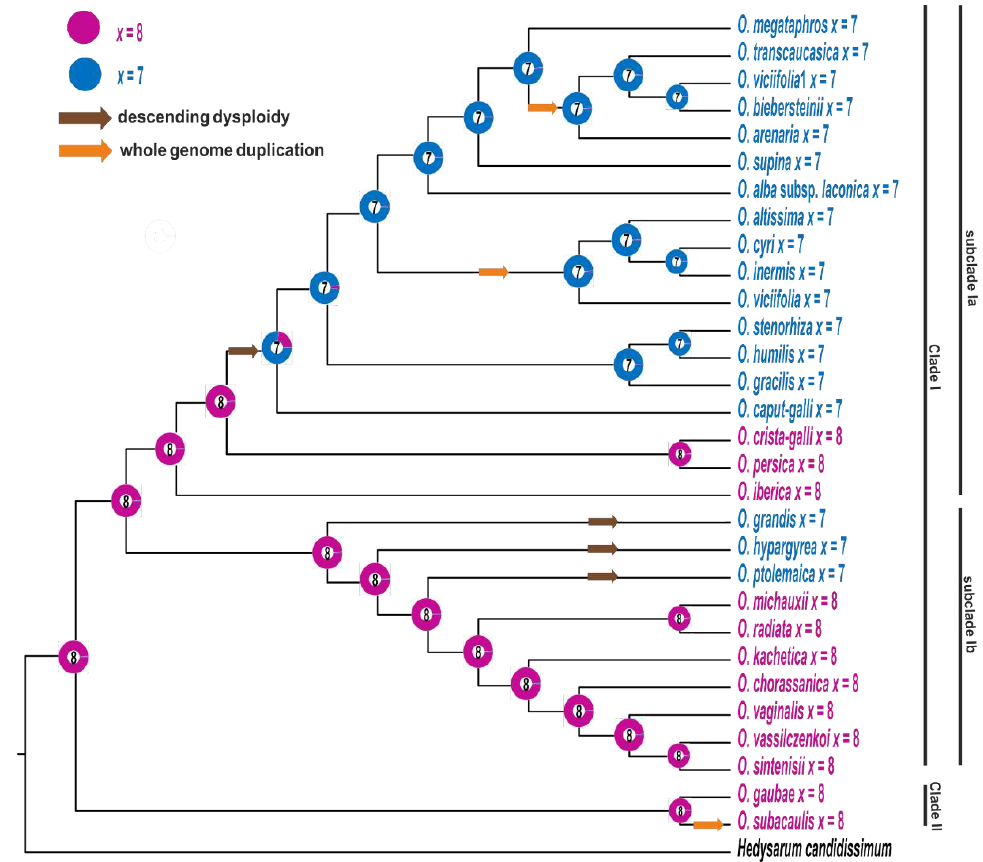
Figure 3. Ancestral character state reconstruction of the basic chromosome numbers of the analysed species of Onobrychis . The chromosome numbers have been mapped on the ML tree of nrITS sequences using the maximum likelihood method implemented in ChromEvol 2.0 software. The tree was rooted with Hedysarum candidissimum.